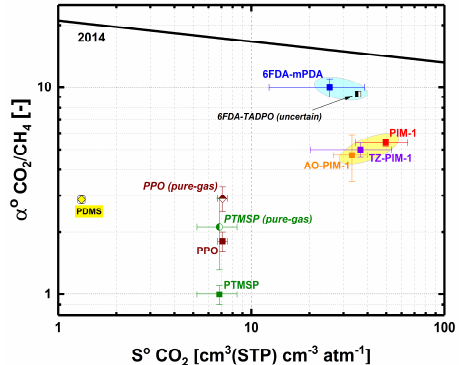
Figure 6. CO 2 solubility coefficient vs. CO 2 /CH 4 solubility selectivity (at infinite dilution) data of all polymers tested for CO 2 -CH 4 mixed-gas sorption at 35 °C [11,15,18,20,22,23,48]. CO 2 /CH 4 solubility selectivities were obtained from linear interpolation of CO 2 mixed-gas solubility coefficient vs. CH 4 mixed-gas solubility coefficient data or from pure-gas uptake data via DMS model equations—see the discussion in the Supporting Information and data values in Table S2. CO 2 solubility coefficients were estimated from experimental data of pure-gas CO 2 uptake. The 2014 CO 2 /CH 4 solubility upper bound was discussed elsewhere